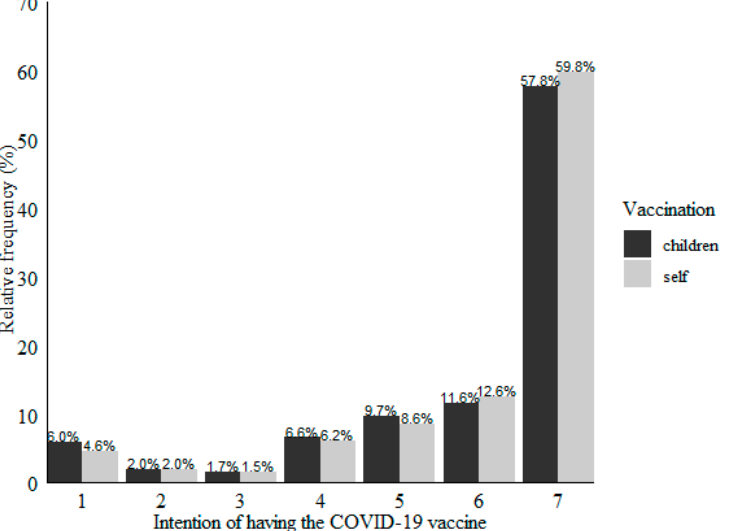
Figure 1. Self and children vaccination intention (1 = “extremely unlikely” to 7 = “extremely likely”).